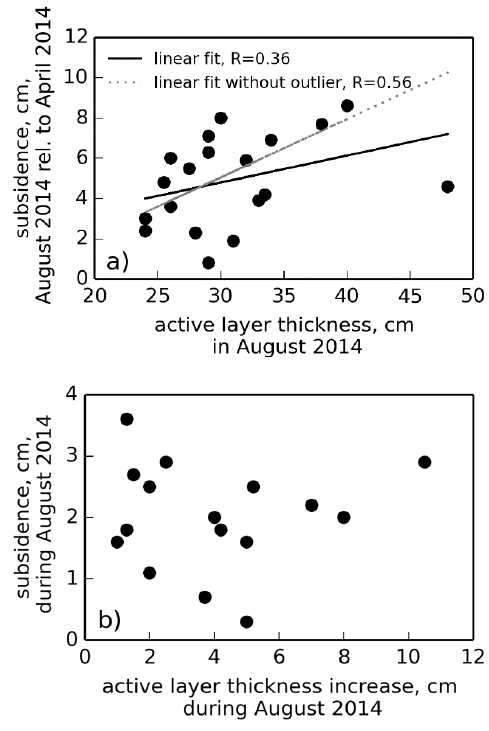
Figure 11. ( a ) Relation between active layer depths measured at the end of August 2014 and seasonal subsidence at the end of August relative to the winter reference level. Removal of an outlier improves the correlation. ( b ) Relation between the increase of active layer depth and increase of subsidence during August 2014.